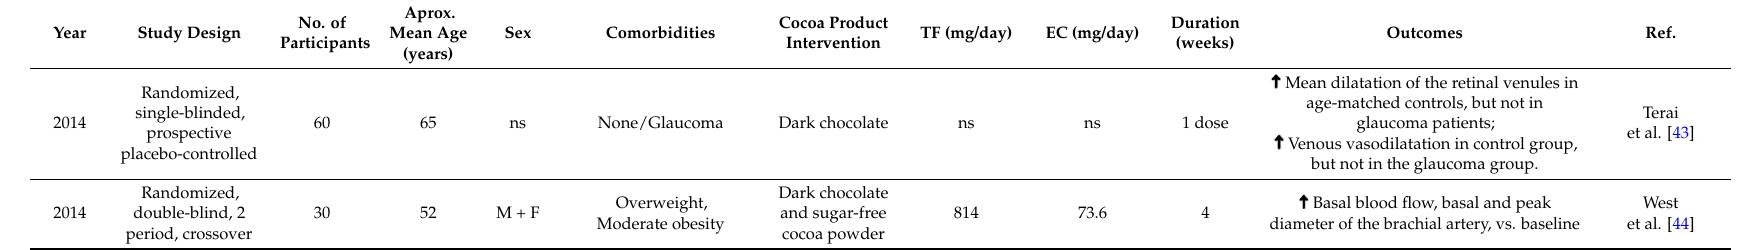
Basal blood flow, basal and peak diameter of the brachial artery, vs. baseline